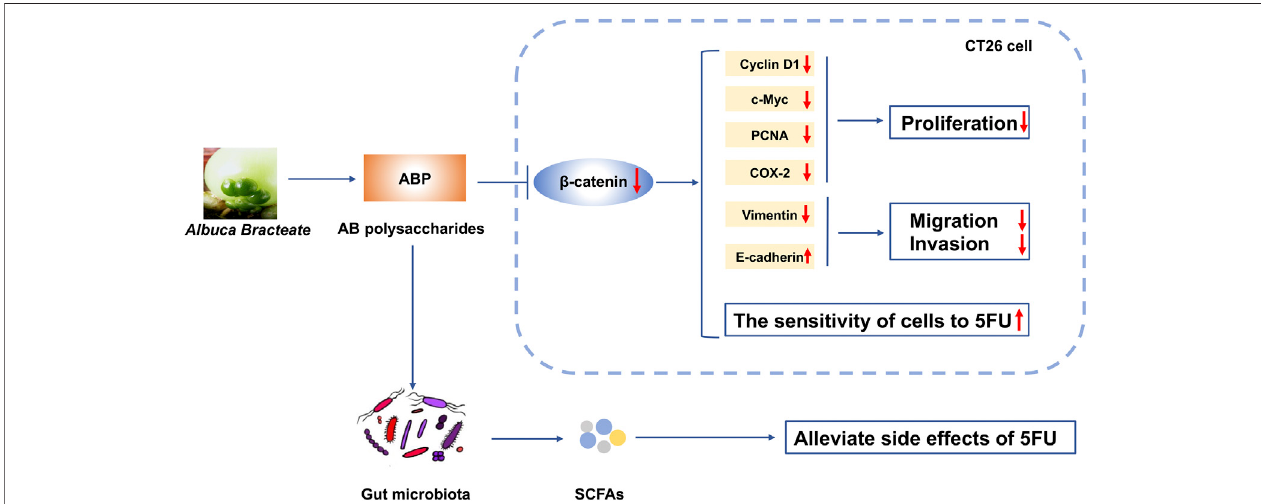
FIGURE 10 | Schematic diagram depicting the mechanism of action underlying the effect of ABP as a regulator of CRC progression. ABP suppresses CRC cell proliferation,migration,andinvasionbyin fl uencingtheWnt/ β -cateninsignalingpathway.ABPtreatmentfurtherincreasesthesensitivityofCRCcellsto5-FUandthereby decreases the incidence of 5-FU-related adverse effects. ABP, Albuca Bracteate polysaccharides; CRC, colorectal cancer.